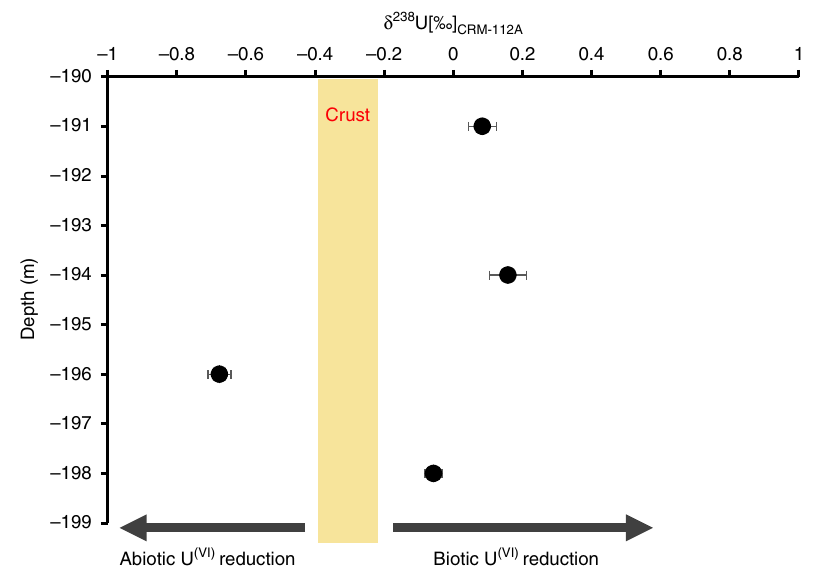
Figure 3 | d 238 U values for U roll-front deposits at four depths. 191.0, 194.0, 196.0 and 198.0. Error bars indicate two s.d. from the mean of triplicate extractions. The yellow box at d 238 U ¼ (cid:2) 0.2 to (cid:2) 0.4 % indicates the average U isotope signature of the Earth’s crust and is often considered as the reference to delineate between abiotic vs biotic U reduction 41,42 . CRM-112A was used as the standard. d 238 U values in ( % ) and depth in